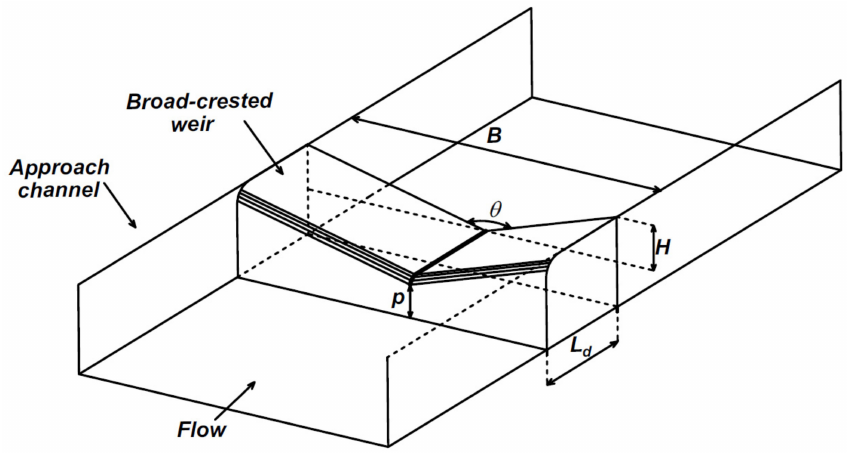
Figure 1. Scheme of the triangular broad-crested weir placed in a rectangular